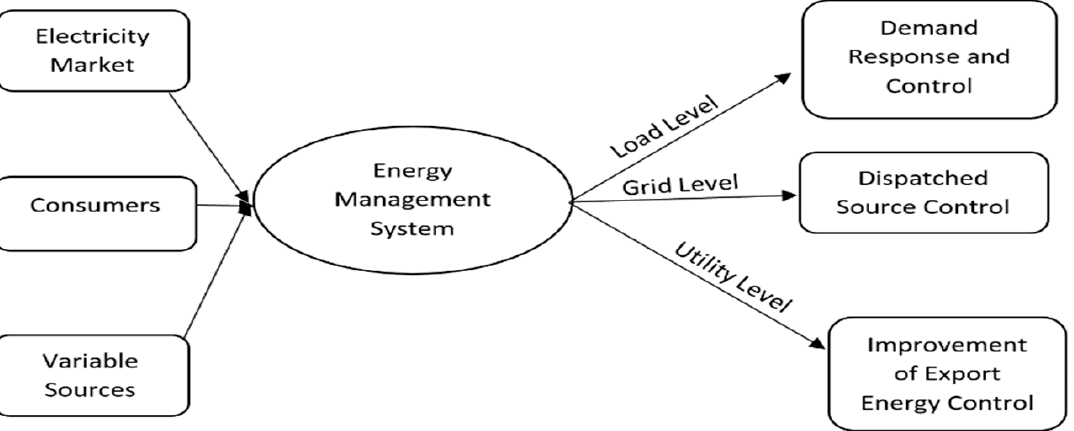
Figure 4. Microgrid Energy Management System.